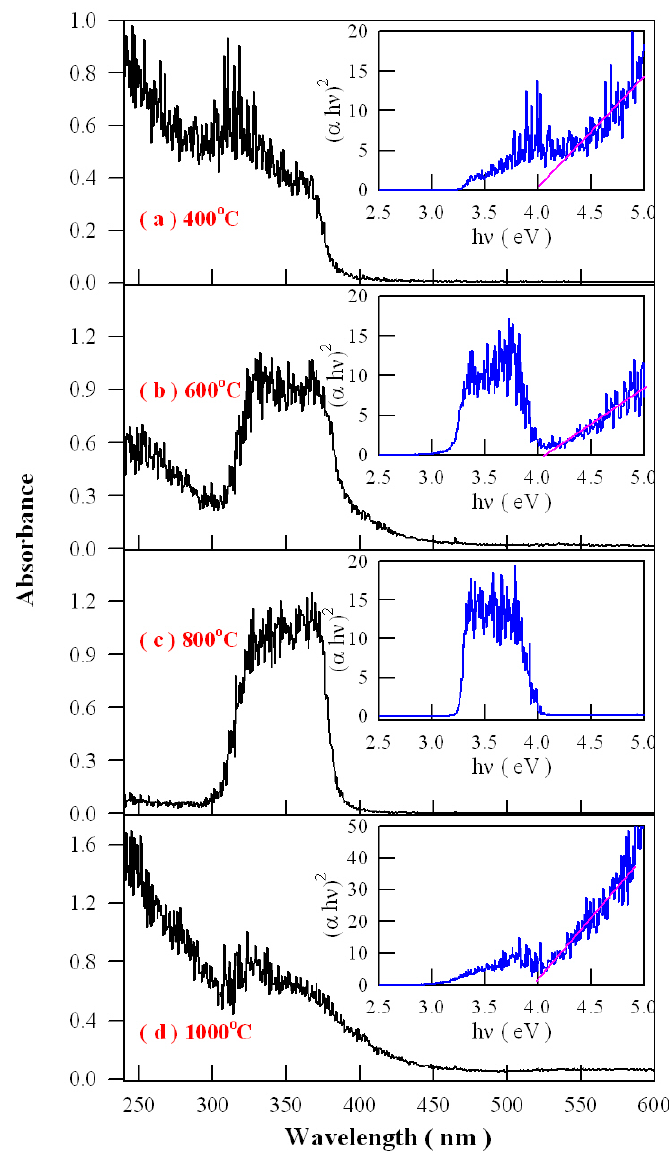
Figure 16. Absorption spectra of Eu-doped ZnWO 4 precursors subjected to annealing at different temperatures: ( a ) 400 °C; ( b ) 600 °C; ( c ) 800 °C; and ( d ) 1000 °C. Inset: Tauc plots to derive bandgap values.